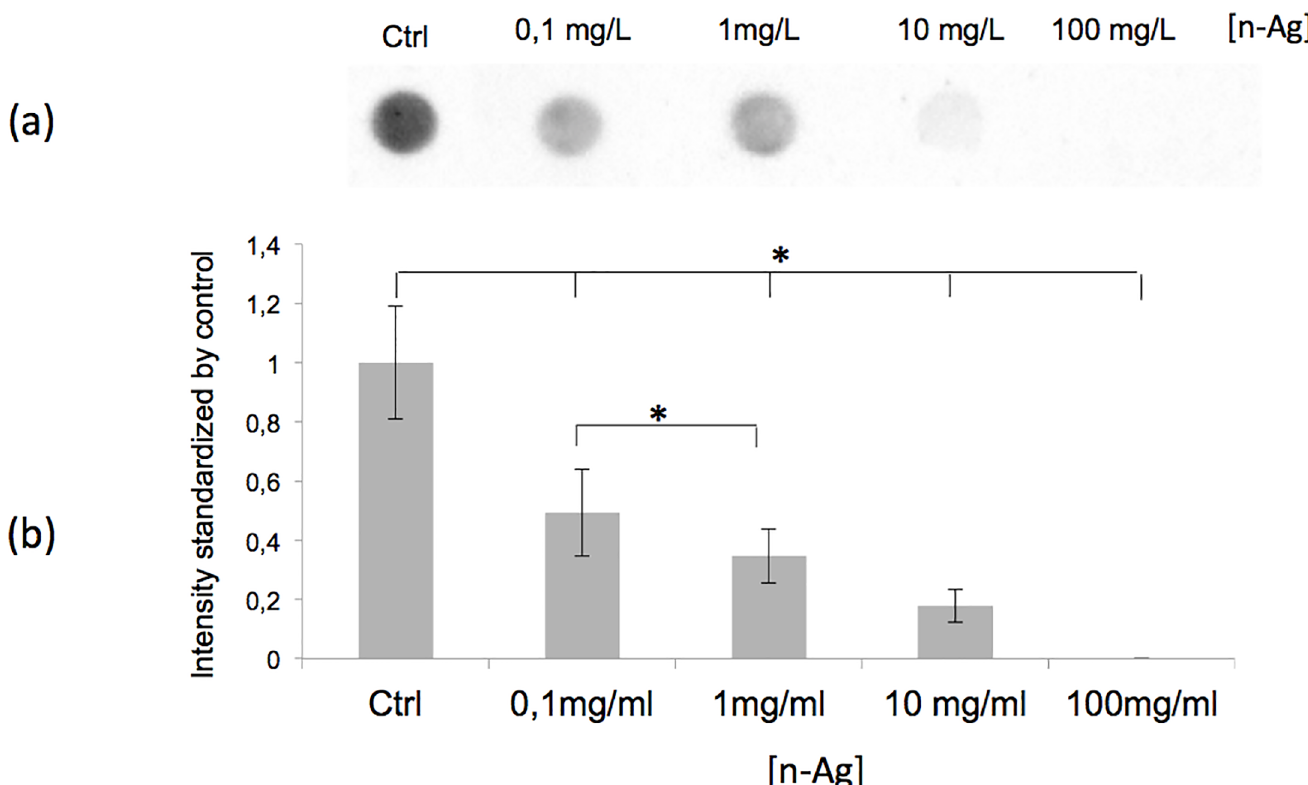
Fig 6. In the cell-free supernatant, the soluble PGA is inversely related to the silver nanoparticle (n-Ag) concentration. (a) Representative dot blot analysis of the soluble PGA in the cell-free supernatant after incubation with n-Ag at different concentrations, ranging from 0 to 100 mg/ml. (b) Quantification of dot blot intensity normalised by the control and the amount of proteins. Error bars ± 1 standard deviation ( n (cid:21) 3). Asterisks ( (cid:3) ) indicate significant differences ( p < 0.05).